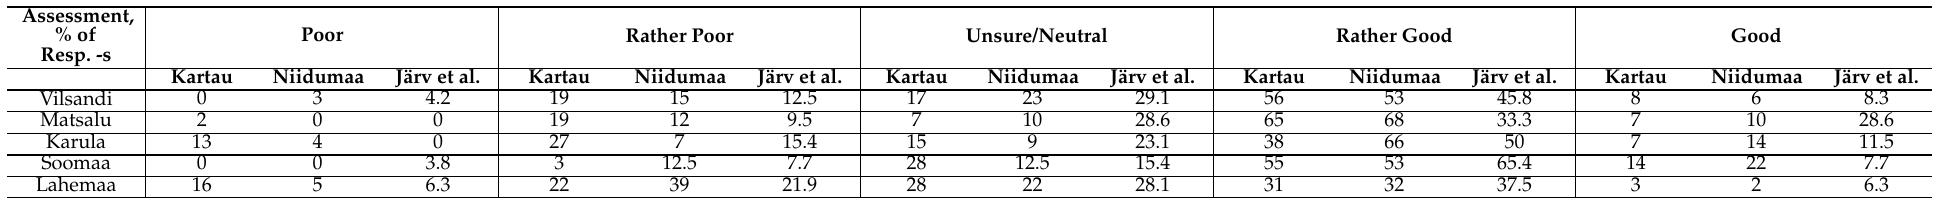
Table 1. Assessment of nature conservation activities in home region, results by park, grouped between three assessments (Kartau, 1998; Niidumaa, 2009; Järv et al., 2021). Assessment, % of Resp.